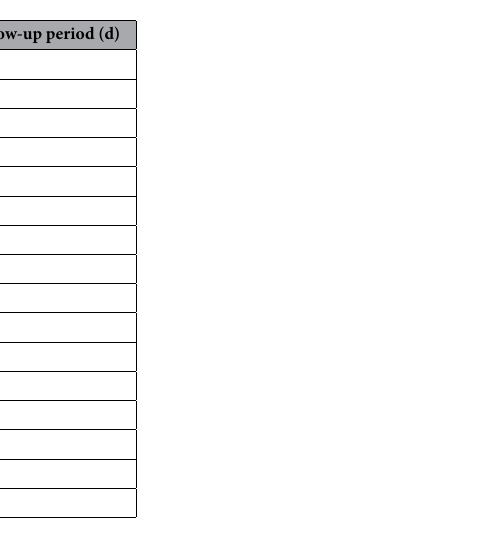
Table 1. Characteristics of patients and study